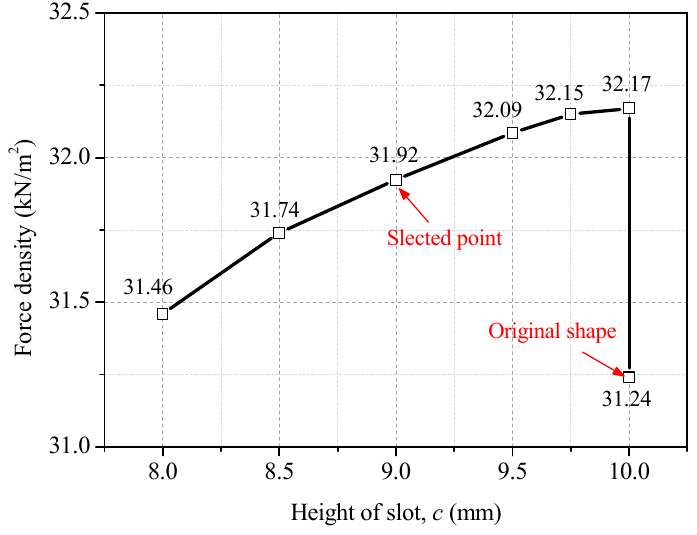
Figure 8. Tangential force density versus the slot height c.